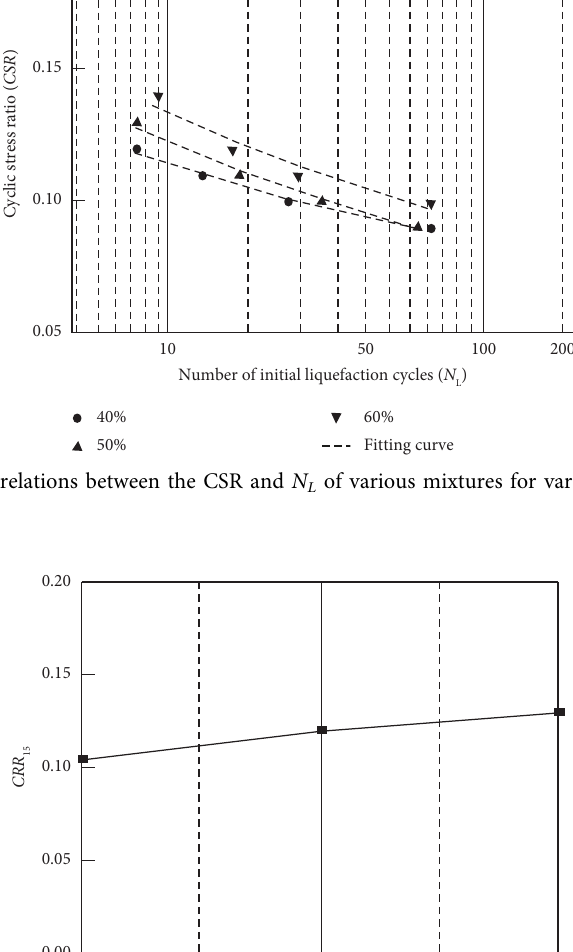
Figure 9: Correlations between the CRR 15 and D r of various mixtures at a constant FC.